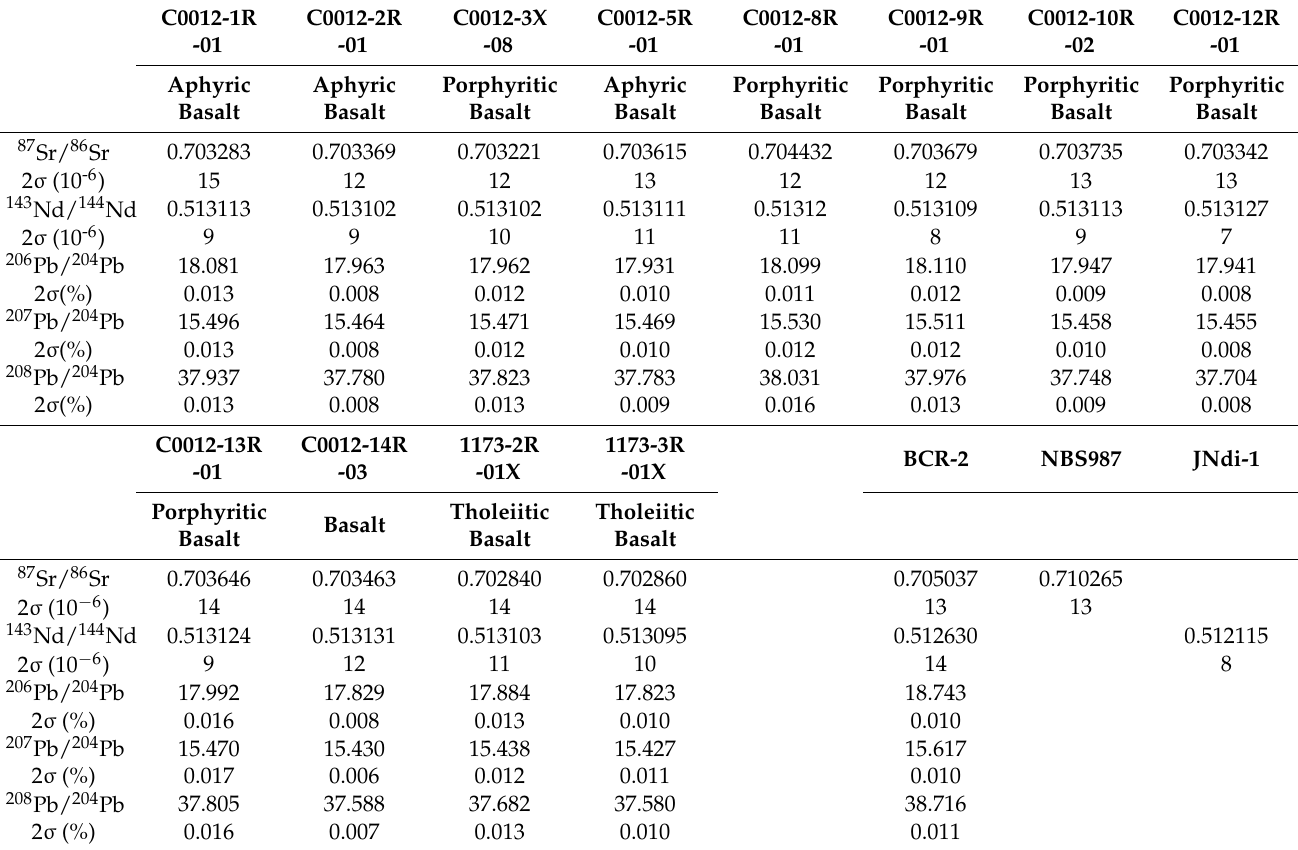
Table 3. Whole-rock Sr, Nd, Pb isotope data of Site C0012 and Site 1173 volcanic rocks from the Shikoku